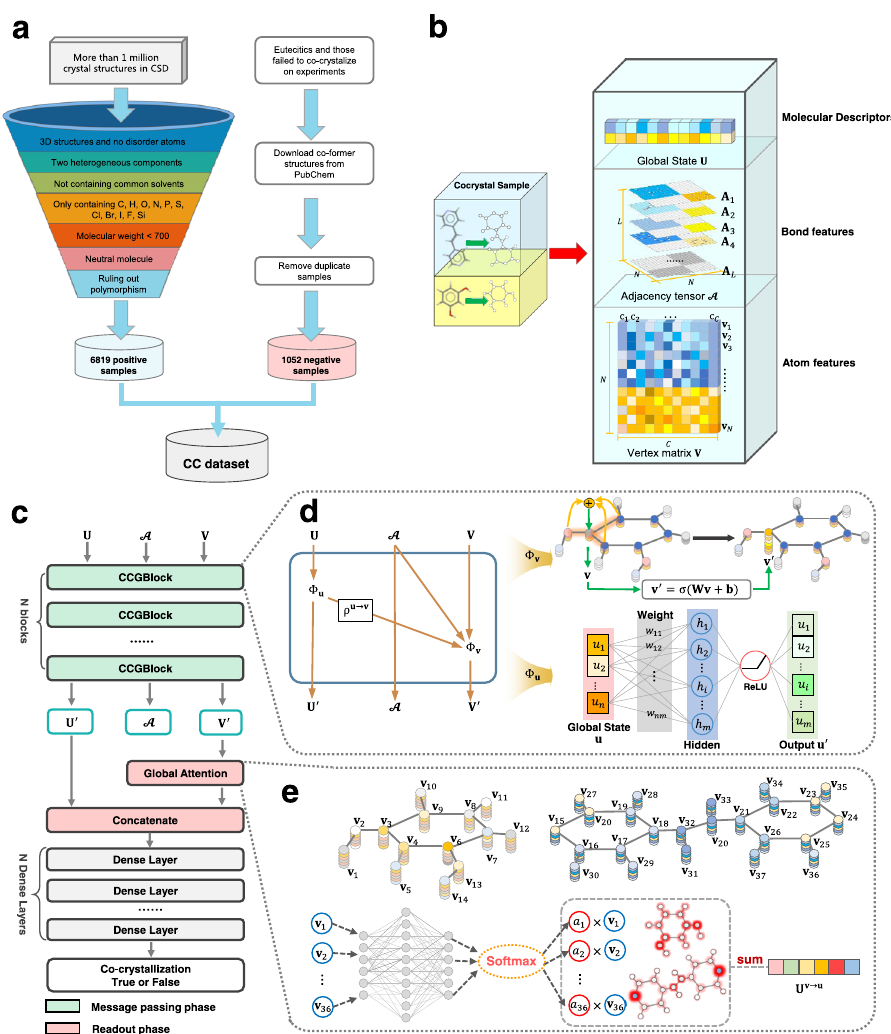
Fig. 1 Overview of CCGNet cocrystal-screening framework. a The fl ow chart of sample collection. Left: the collection of cocrystal positive samples. Right: the collection of cocrystal negative samples. b Sample Representation. c The architecture of the CCGNet model. Green and pink denote the calculation block at the message passing phase and the readout phase, respectively. d Customization of CCGBlock. Φ u is the global state function realized by a single- layer feedforward neural network while Φ v is a Graph-CNN layer to propagate and update node information. ρ u ! v is a concatenation operation, which embeds hidden representation of u into atom vectors of each coformer. σ is activation function. e Illustration of the global attention. v i is node embedding. a a v ! u is a weighted summation of products of v i is the attention weight of each node. U i and i